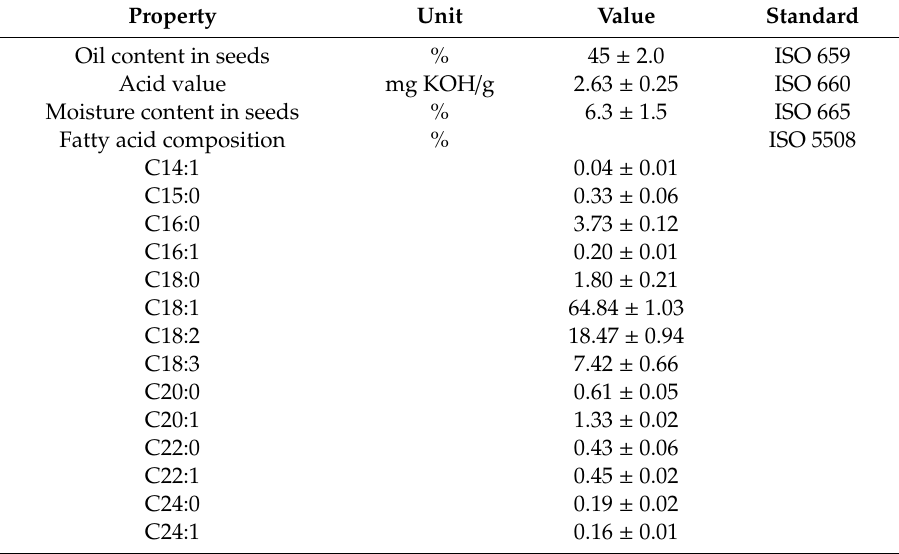
Table 1. The properties of rapeseed and its